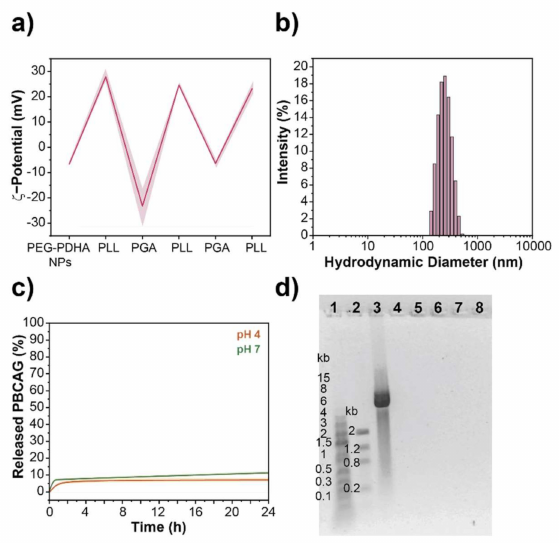
Figure 4. Layer-by-layer engineered PEG-PDHA nanoformulation. ( a ) The ζ -potential of PEG- PDHA NPs during layer-by-layer assembly process. ( b ) Hydrodynamic size distribution of layer-by- layer engineered PEG-PDHA nanoformulation. ( c ) Release kinetics of PBCAG from layer-by-layer engineered PEG-PDHA nanoformulation. ( d ) Representative gel electrophoresis of PBCAG release from layer-by-layer engineered PEG-PDHA nanoformulation. Well 1: 1 kb DNA ladder, Well 2: low DNA mass ladder, Well 3: PBCAG (6.34 kb), Well 4–8: PEG-PDHA NPs encapsulating PBCAG after 0, 0.5, 1, 3, and 24 h incubation at 37 ◦ C, respectively.